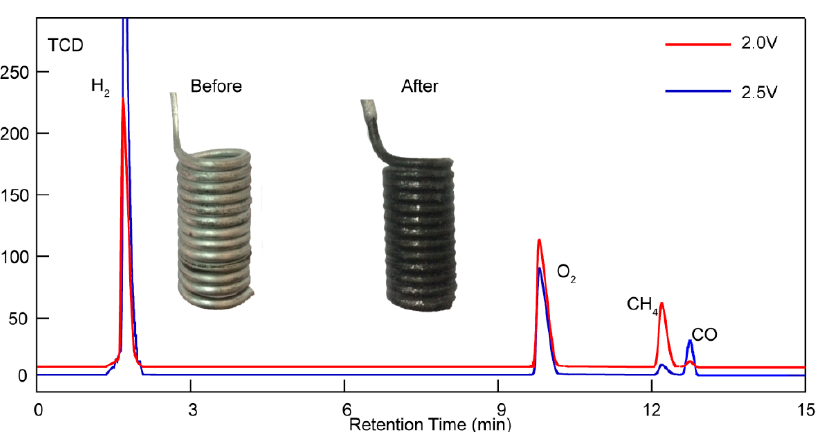
Figure 6. Gaseous products analysis results of Li 1.427 Na 0.359 K 0.214 CO 3 +0.15LiOH under 2.0 V (red line) and 2.5 V (blue line) at 550 °C with a 20 cm 2 Ni anode and Fe cathode, as well as a digital photo of line) and 2.5 V (blue line) at 550 ◦ C with a 20 cm 2 Ni anode and Fe cathode, as well as a digital photo the Fe cathode before and after electrolysis. of the Fe cathode before and after